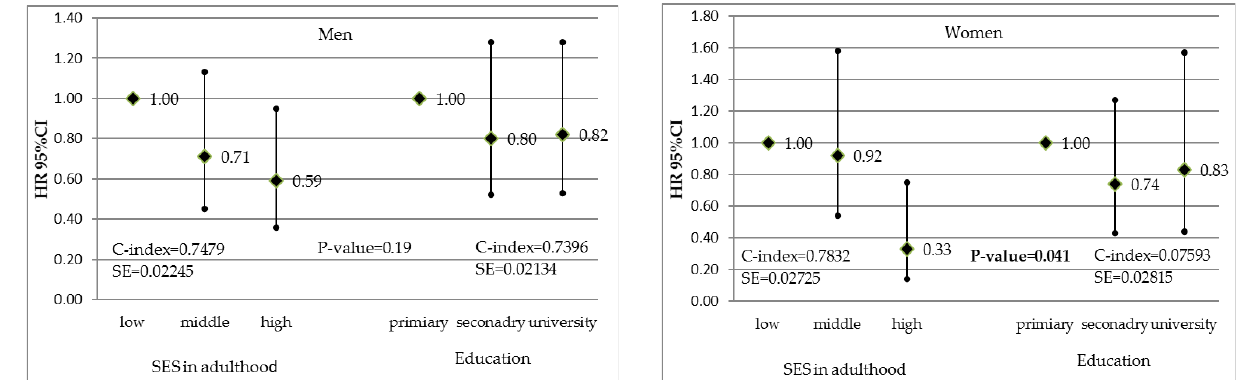
Figure 1. Associations between the socioeconomic status index in adulthood and education, and cardiovascular disease incidence in men and women. Hazard ratios adjusted for age, marital status, obesity, hypertension, hypercholesterolemia, smoking, and diabetes.